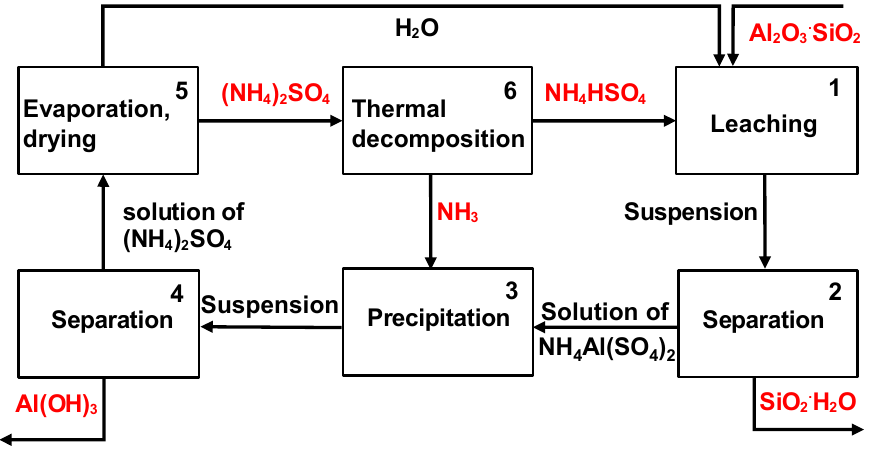
Figure 1. Principal flowchart of the Buchner circular process.